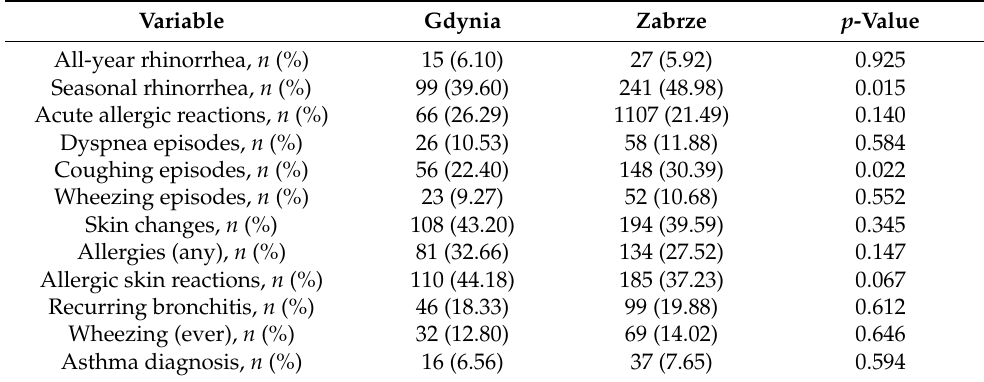
Table 4. Allergic and respiratory symptoms in schoolchildren in Gdynia and